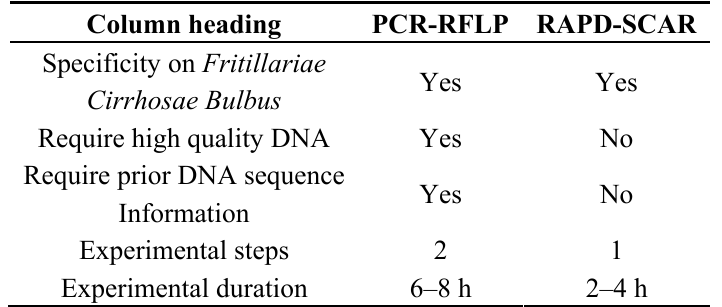
Table 3. The characters of PCR-RFLP and RAPD-SCAR